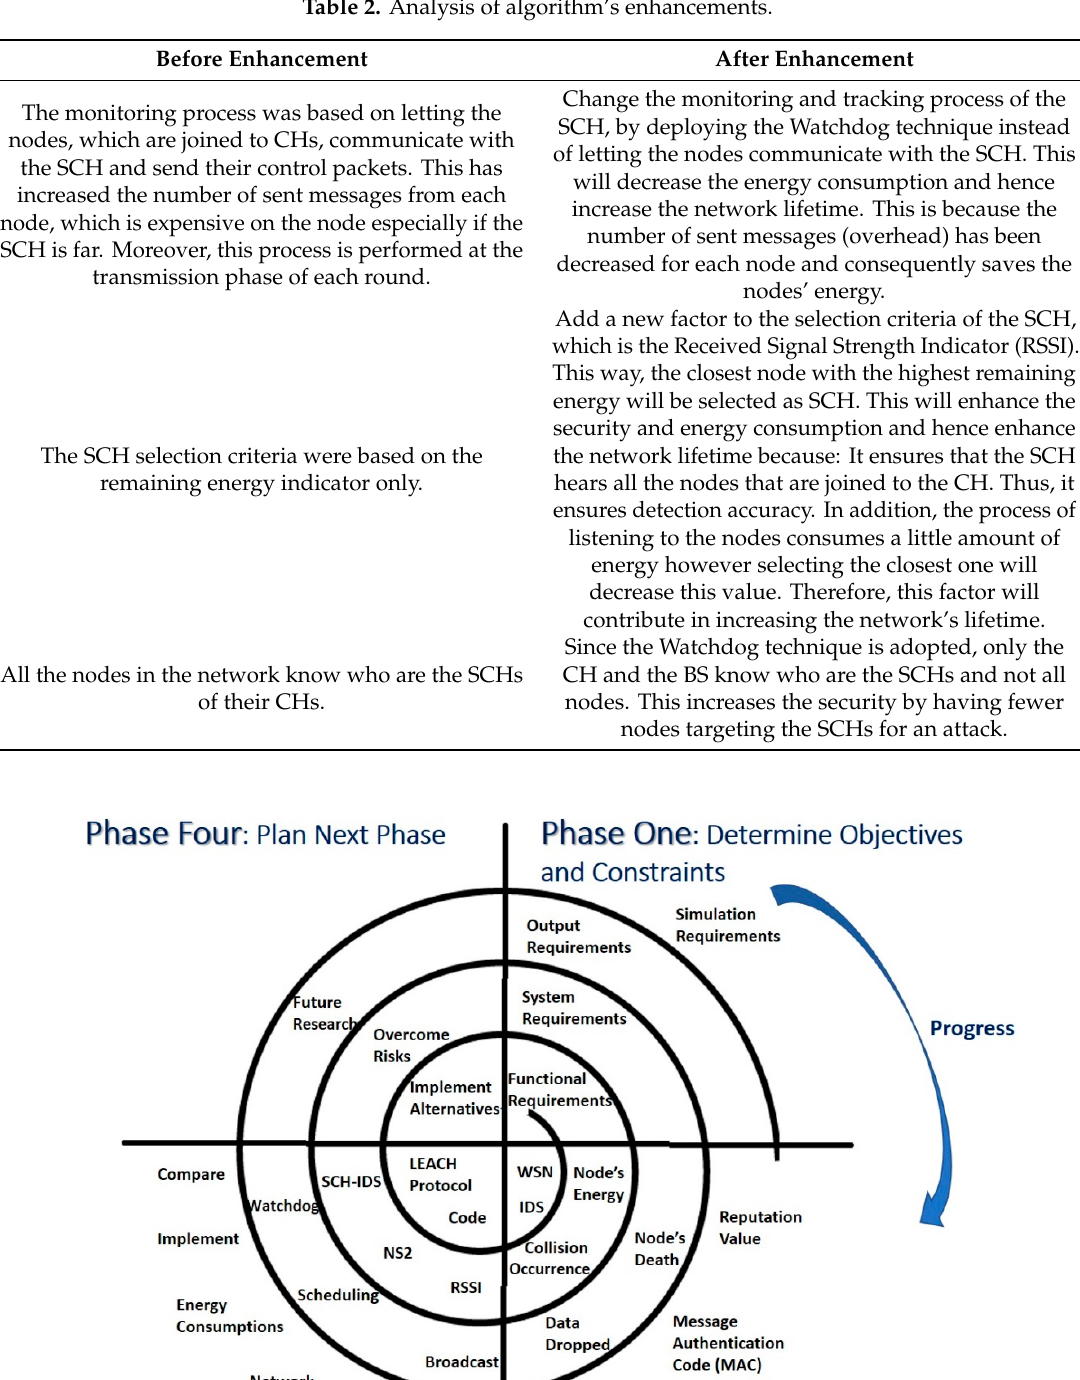
Table 2. Analysis of algorithm’s enhancements.